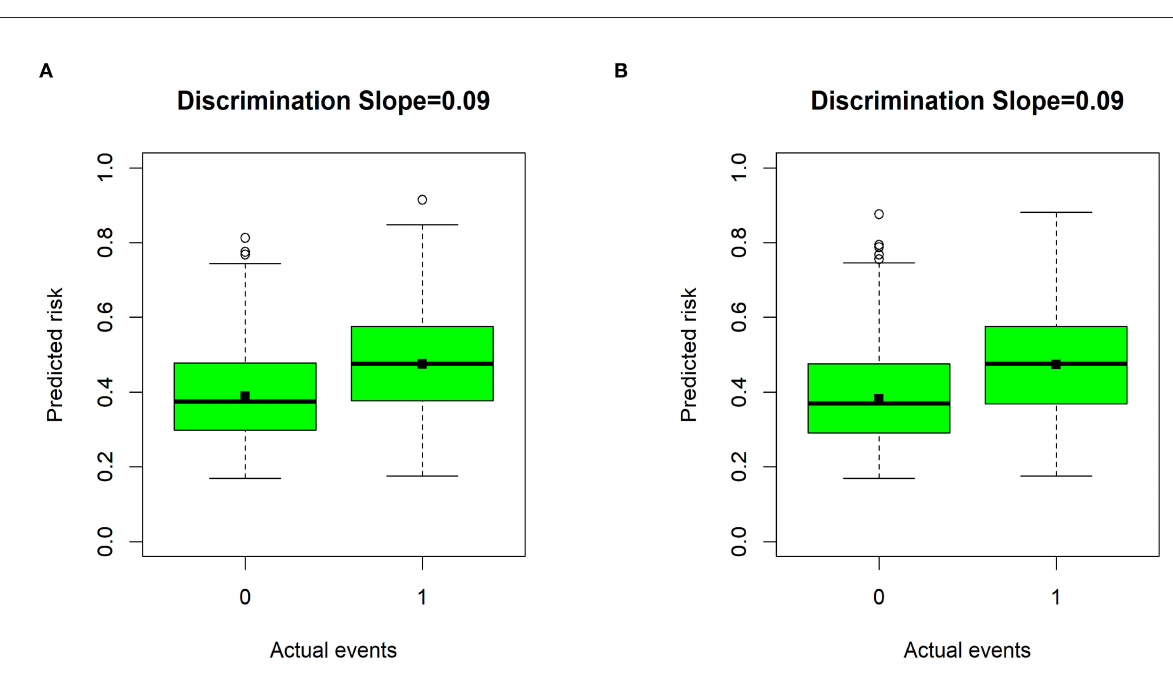
one another to avoid and shirk responsibility, when there were medical disputes between management divisions (